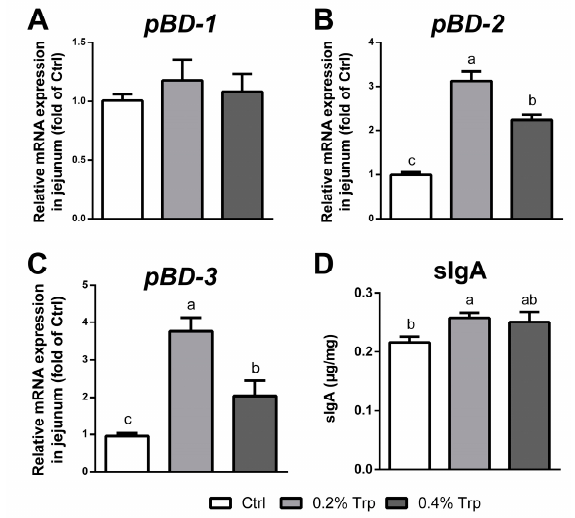
Figure 1. Protein abundances of ZO-1, ZO-3, claudin-1, and occludin in the jejunum of weaned piglets receiving dietary supplementation with 0% (Control, Ctrl), 0.2%, or 0.4% Trp. Western blot analyses of ZO-1 ( A ), ZO-3 ( B ), claudin-1 ( C ), and occludin ( D ) were performed. Values are means ± SEM, n = 6. Means without a common letter differ, p < 0.05.